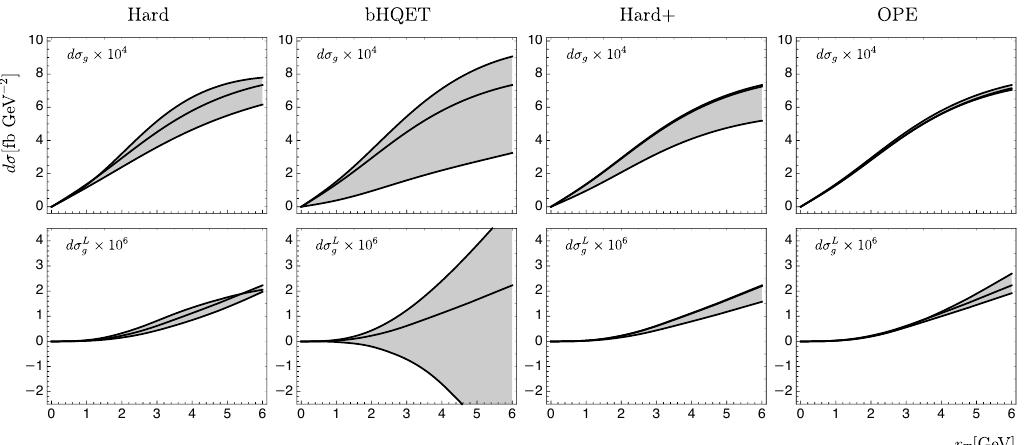
Figure 5. Cross-sections for HHP production at EIC with error-bands coming from scale de- pendence in hard factor (Hard), heavy meson jet function (bHQET), heavy meson jet function matching coefficient (Hard+) and Wilson coefficients (OPE). The rows correspond to contributions from total cross-section (top) and linearly polarized gluons (bottom). η 1 = η 2 = 0